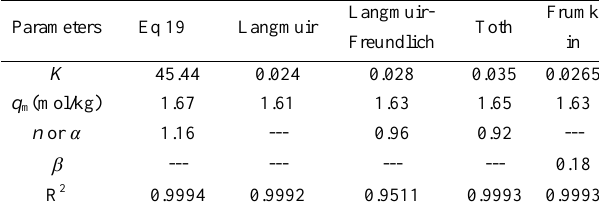
Table 4. The obtained parameters of isotherms for C adsorption on zeolite 13x at 343.15